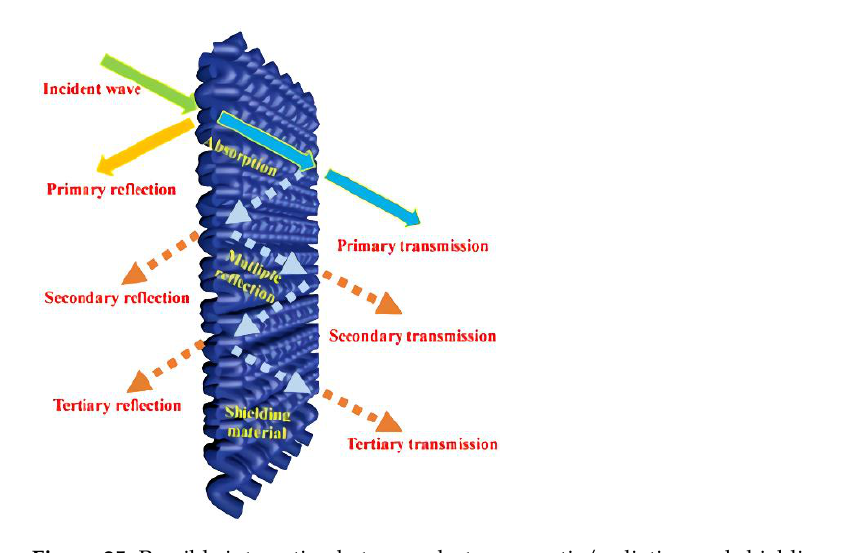
Figure 25. Possible interaction between electromagnetic/radiation and shielding materials [168].